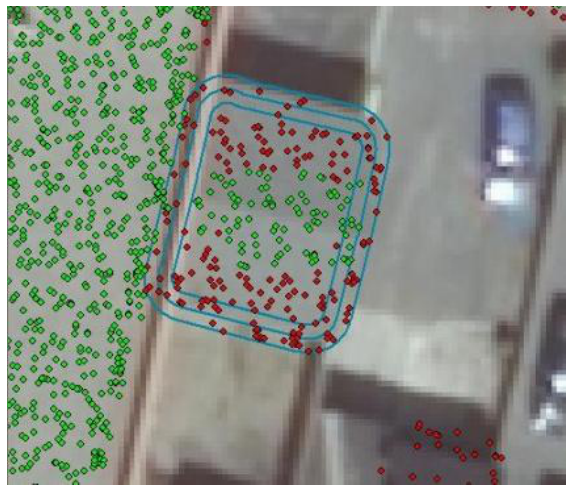
Figure 6. Using 3.5 m as cutoff for small houses eliminates 50% of the correct roof points.